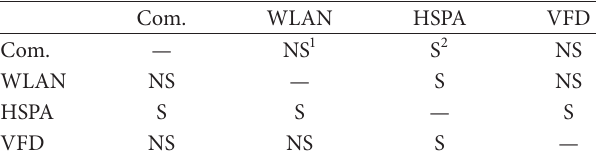
Table 7: Kruskal-Wallis nonparametric analysis of variance test to statistically compare(at 𝛼 ≤ 0.05 )theobjective results(PSNR)of the investigated wireless transmission scenarios for 560×416 resolution